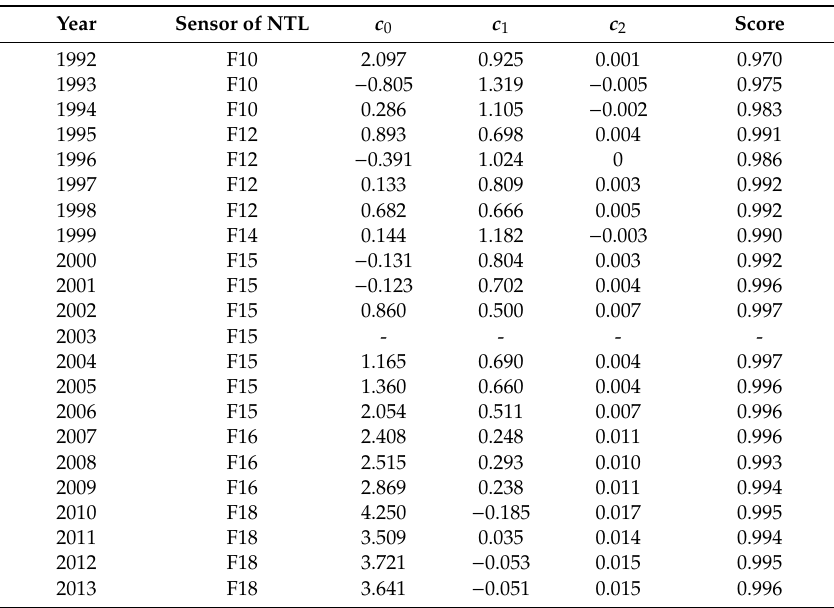
Table 2. Intercalibration of DMSP annual composites in 1992–2013.